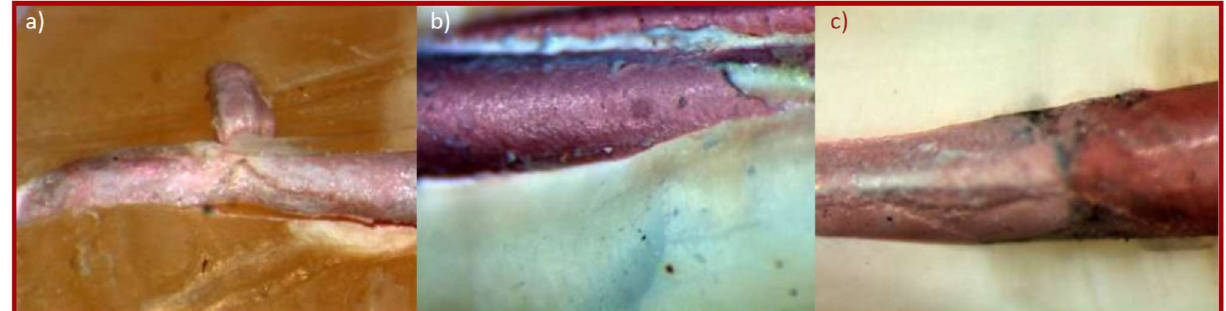
Figure 13. Results of observations in a light stereoscopic microscope of teeth after filling the root canal with filling material based on polymeric Resilon-type polyester materials, covered with a thin intermediate layer of sealant: ( a ) lateral canal filled with a thermoplastic method (50×); ( b ) joining the main stud with the complementary studs with a sealant in the middle part of the root canal after filling with the cold lateral condensation method (50×); ( c ) joining the main stud with the filling material, sealed with a thin layer of sealant in the middle part of the root canal after filling with the thermoplastic method (50×).